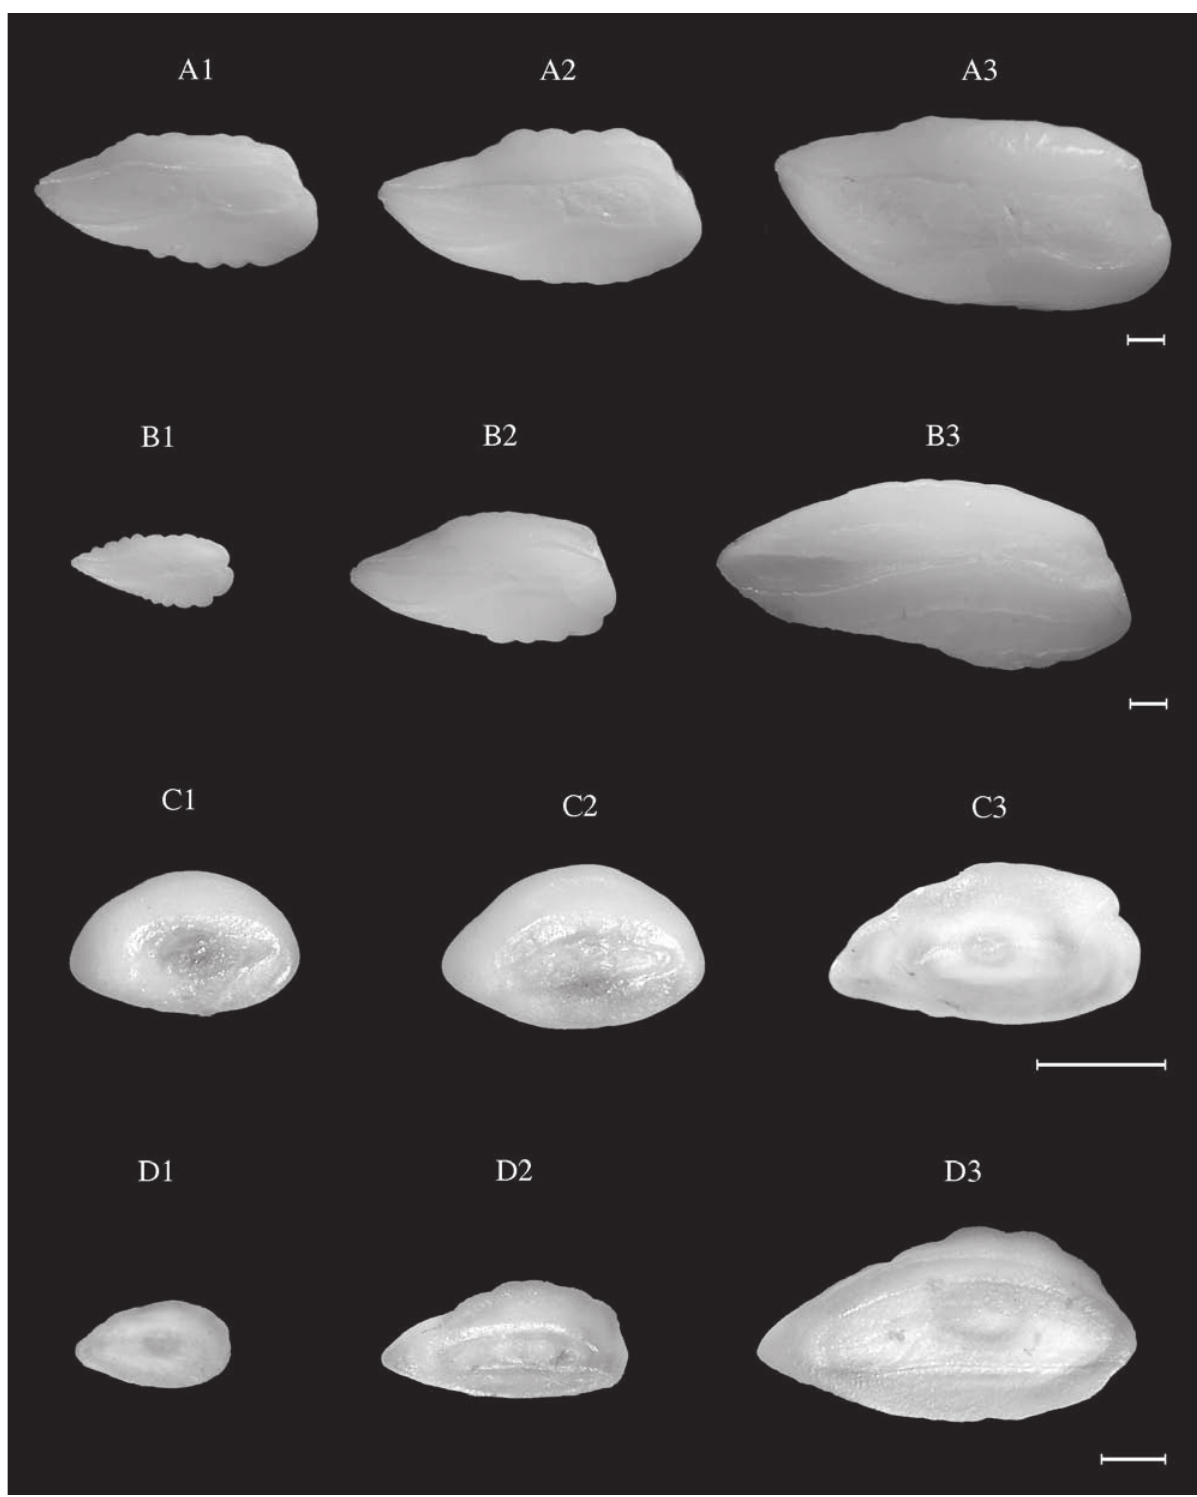
Fig. 32. – Trisopterus luscus (NEA). TL: A1 13.9 cm; A2, 21.3 cm; A3, 27.2 cm. Trisopterus minutus . TL: B1, 7.5 cm (NEA); B2, 14.7 cm (NEA); B3, 24.0 cm (WM). Carapus acus (WM). TL: C1, 8.0 cm; C2, 8.5 cm; C3, 12.0 cm. Echiodon dentatus (WM) . TL: D1, 13.0 cm; D2, 14.7 cm; D3, 18.5 cm. Scale bar = 1